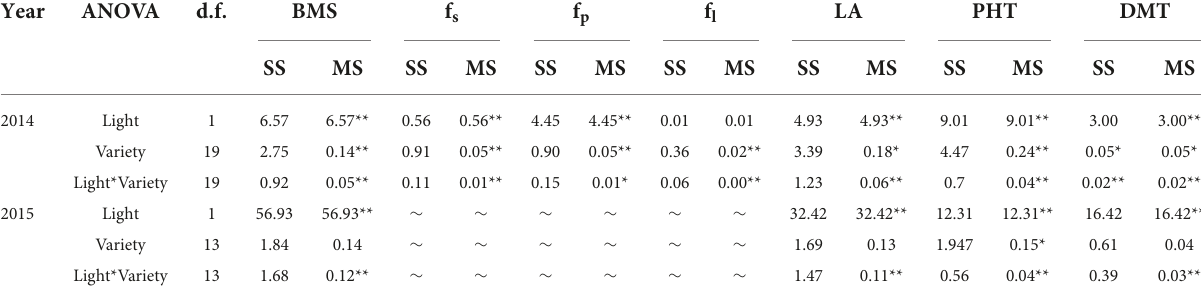
TABLE 1 The sum of squares (SS) and mean squares (MS) of two-way ANOVAs of the effects of light and variety on morphological